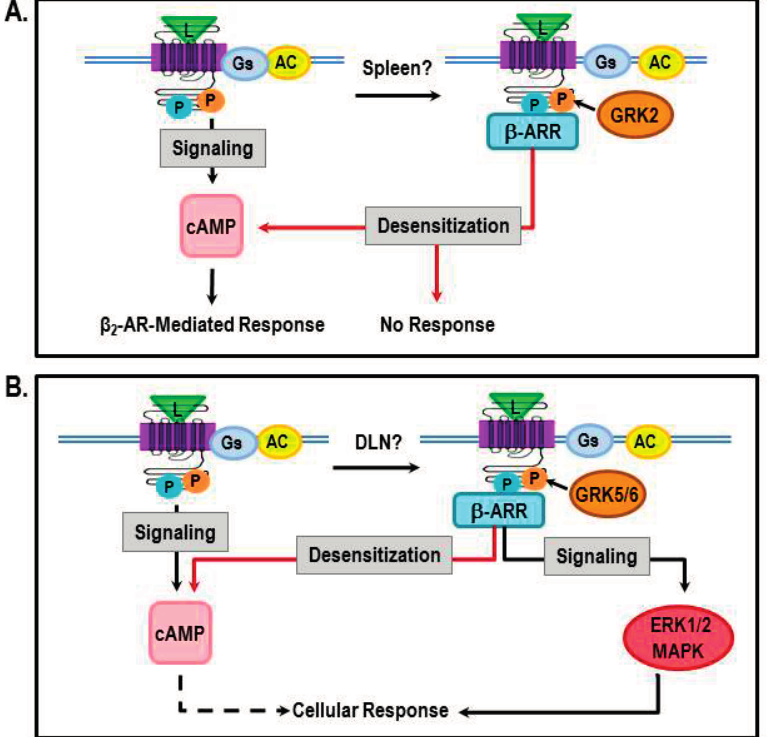
Figure 11. Findings from our laboratory using an animal model of the autoimmune disease, RA, reveal disease-related changes in β 2 -AR signaling that are dependent upon the lymphoid tissue examined. Here, we illustrate our proposed model to explain the different receptor signaling in spleen ( A ) and lymph nodes that drain the arthritic hind limbs (DLN) ( B ). ( A ) In the spleen, classical signaling via cAMP-PKA (shown on left side) is abolished and β 2 -AR agonists fail to inhibit the production of IFN- γ . High SNS tone caused by high levels of circulating inflammatory cytokines, results in PKA and GRK2 phosphorylation of β 2 -ARs in Th1 cells (shown on right side). Phosphorylation by PKA and GRK2 then induces receptor desensitization, thus β 2 -AR agonists fail to decrease IFN- γ production. For comparison, the canonical signaling pathway for β 2 -ARs is shown on the left. ( B ) In the DLN of arthritic rats, β 2 -AR agonists increase the production of IFN- γ . This finding supports a shift in receptor signaling away from the classical pathway (left side) towards the non-canonical pathway (right side). In the proposed model, high SNS nerve firing in the DLN coupled with high local levels of inflammatory cytokines induces β 2 -AR phosphorylation by PKA and is phosphorylated byGRK5/6. Phosphorylation by GRK5/6 leads to the recruitment of β -arrestin-2 to the receptor. Beta-arrestin-2 then switches receptor signaling to a β -arrestin-dependent activation of ERK1/2. ERK1/2 is well known to promote IFN- γ